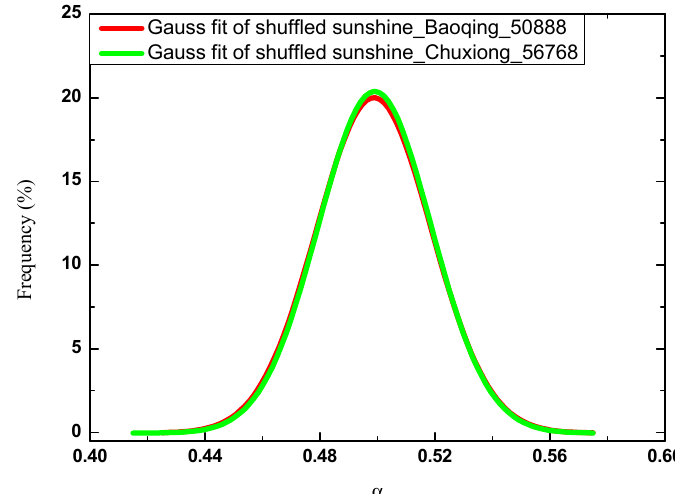
Figure 4. The Gaussian fit of frequency in DFA-exponents after shuffling the SSDA records 10,000 times at stations Baoqing and Chuxiong.